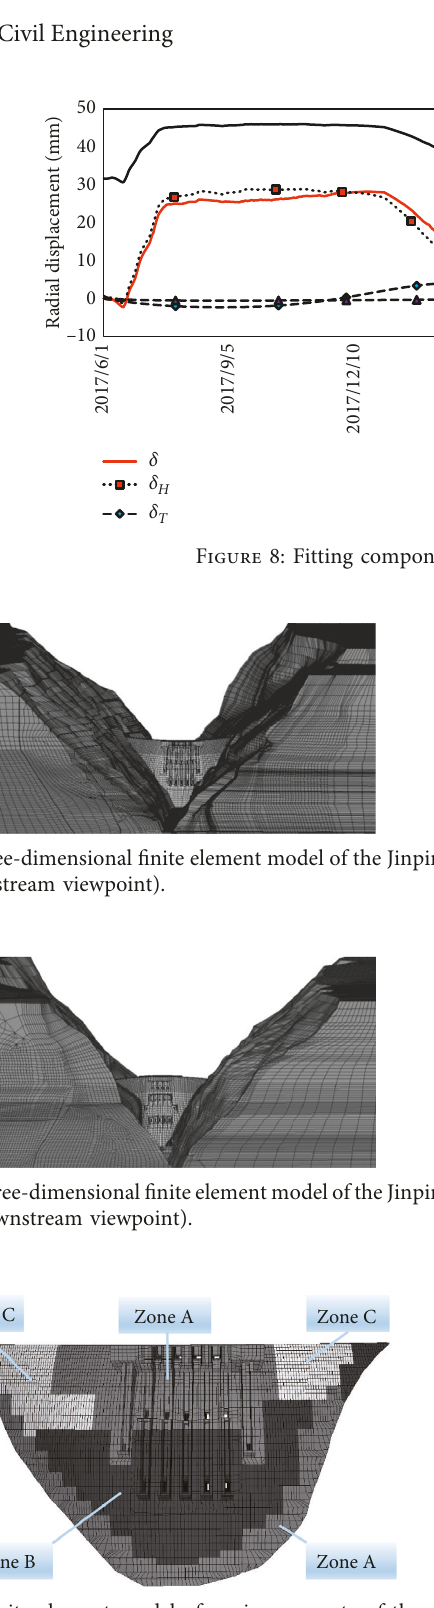
Figure 11: Finite element model of zoning concrete of the dam body.